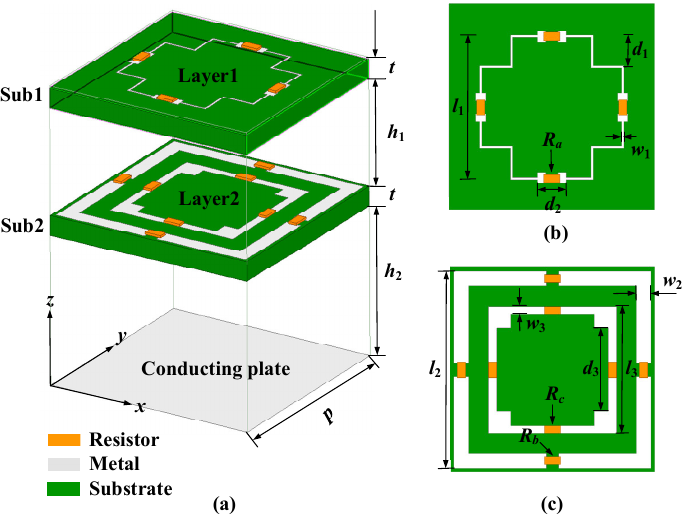
Figure 1. Schematic diagram of the proposed absorber unit structure. ( a ) The overall schematic diagram of the unit structure, the detailed structural schematic diagram of ( b ) Layer 1 and ( c ) Layer 2.